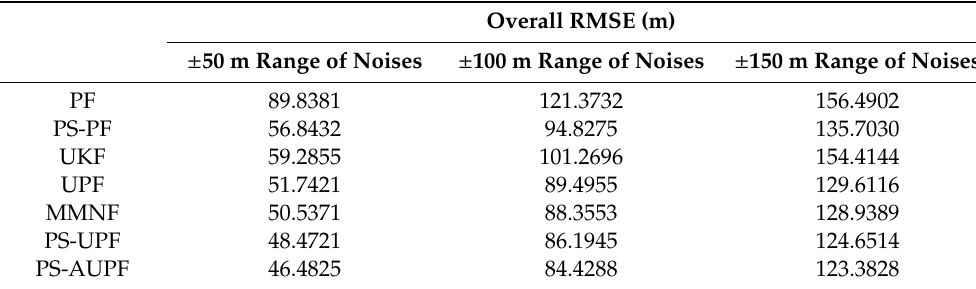
Table 3. Tracking RMSE of each algorithm with Uniform noise.